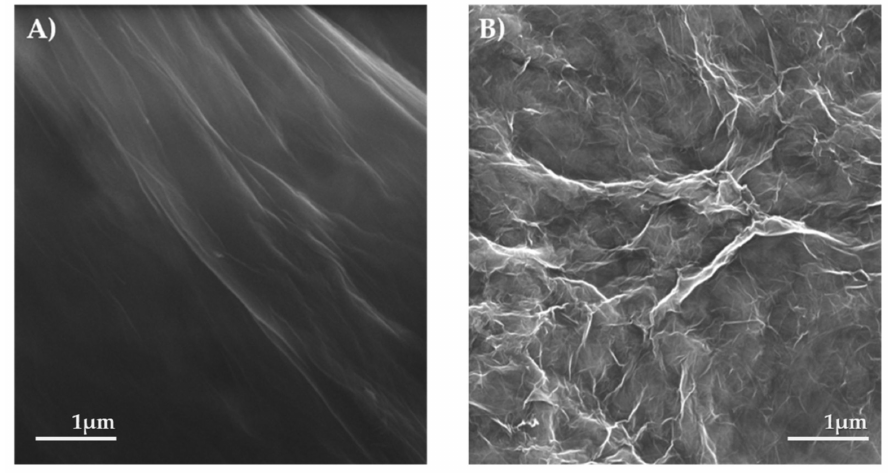
Figure 2. Images obtained from scanning electron microscope (SEM). ( A ) Graphene oxide (GO) and ( B ) reduced graphene oxide (rGO) with 1 µ m scale